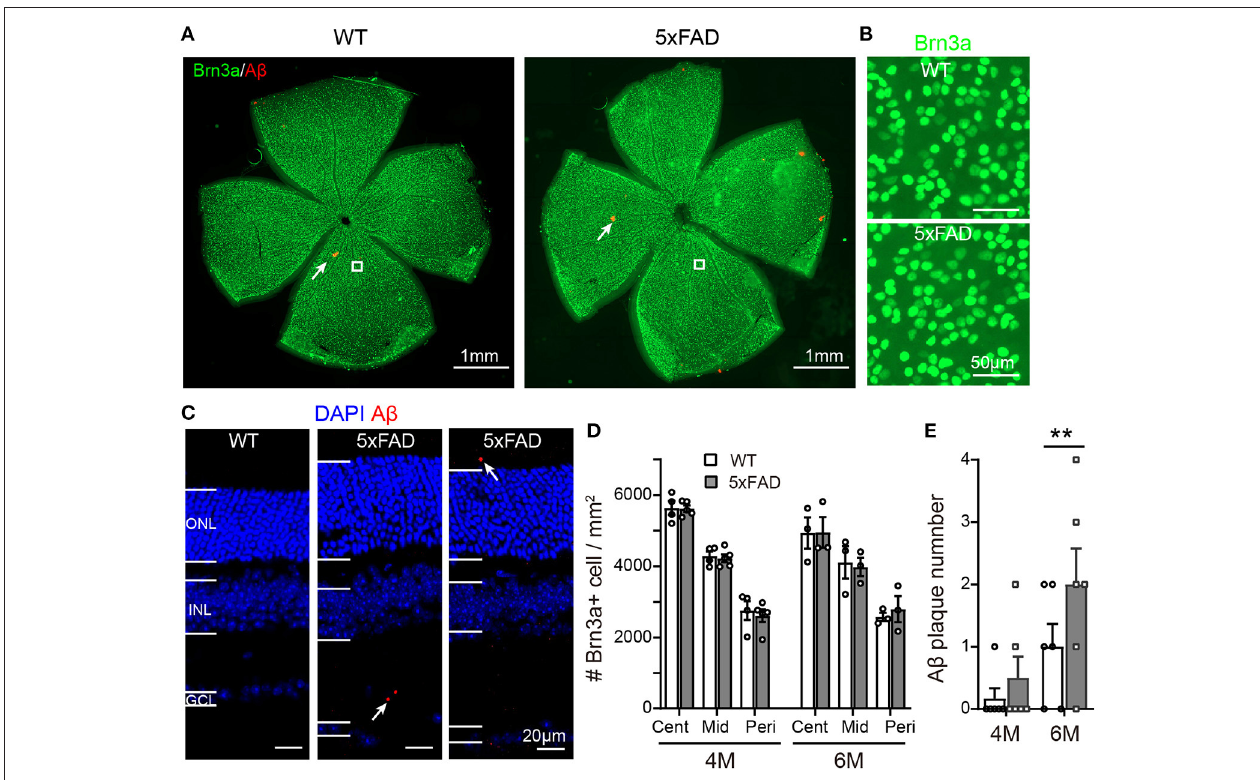
FIGURE 7 | Density of retinal ganglion cells is normal in 5xFAD but a few A β plaques emerge in retina at 6 months. (A) Example of Brn3a staining of RGCs (green) and A β plaque deposition (red, examples indicated by white arrows) from a whole mount retina of a WT and 5xFAD mice at 6 months; the white square from similar eccentricity is shown in Panel (B) at higher magnification. (C) Images of retinal slices stained with DAPI and A β plaque deposition (red, points by white arrow). (D) Scattered plot of the Brn3a-positive cell density in whole mount retina at central (cent), middle (mid), and peripheral (peri) regions (corresponding to 300, 1,000, and 1,700 µ m away from the center of the optic disk, respectively). The RGCs density in 5xFAD is similar to that of WT at both 4 and 6 months. (E) Scattered plot of A β plaque number in retinal slices (accumulated from three slices for each animal). ** p < 0.01; two-way